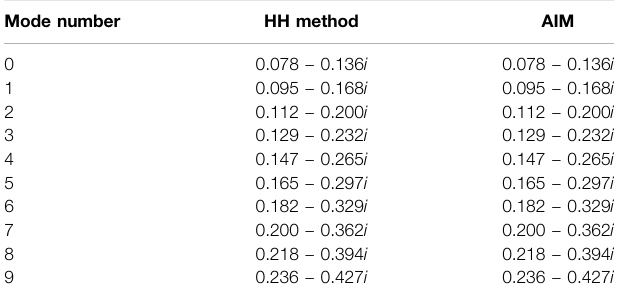
TABLE 1 | First ten QNFs of the Klein-Gordon fi eld produced by the HH method and by the AIM. We take r + (cid:1) 70 and m (cid:1) 1/10. Mode number